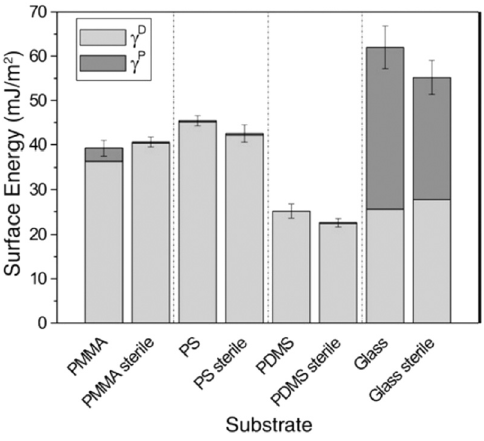
Figure 4: Total surface energy of di ff erent materials ( reproduced from ref. [ 52 ]) .